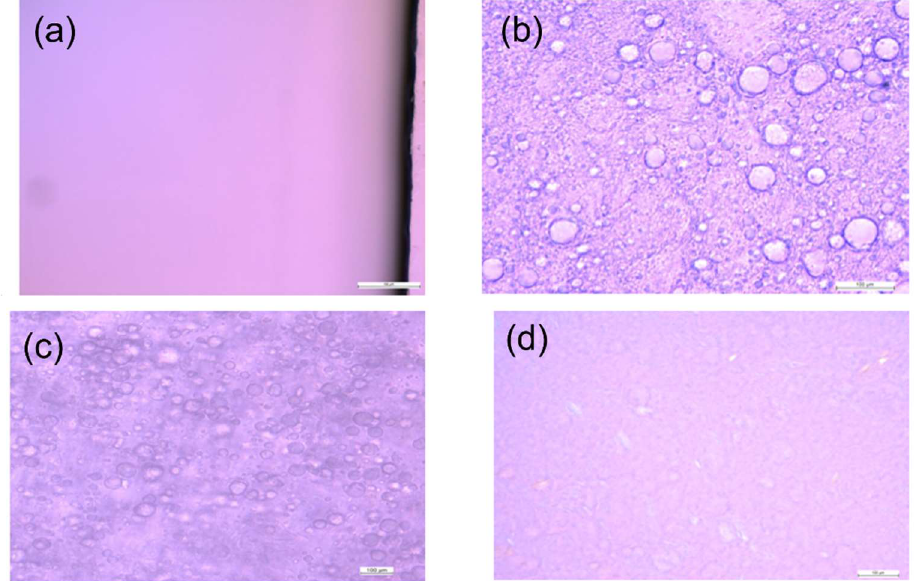
Figure 1. Microscopic observation of ( a ) Gel, ( b ) Emulgel, ( c ) Emulsion, and ( d ) Ointment at 400× magnification. Scale bar represents 100 µ m.